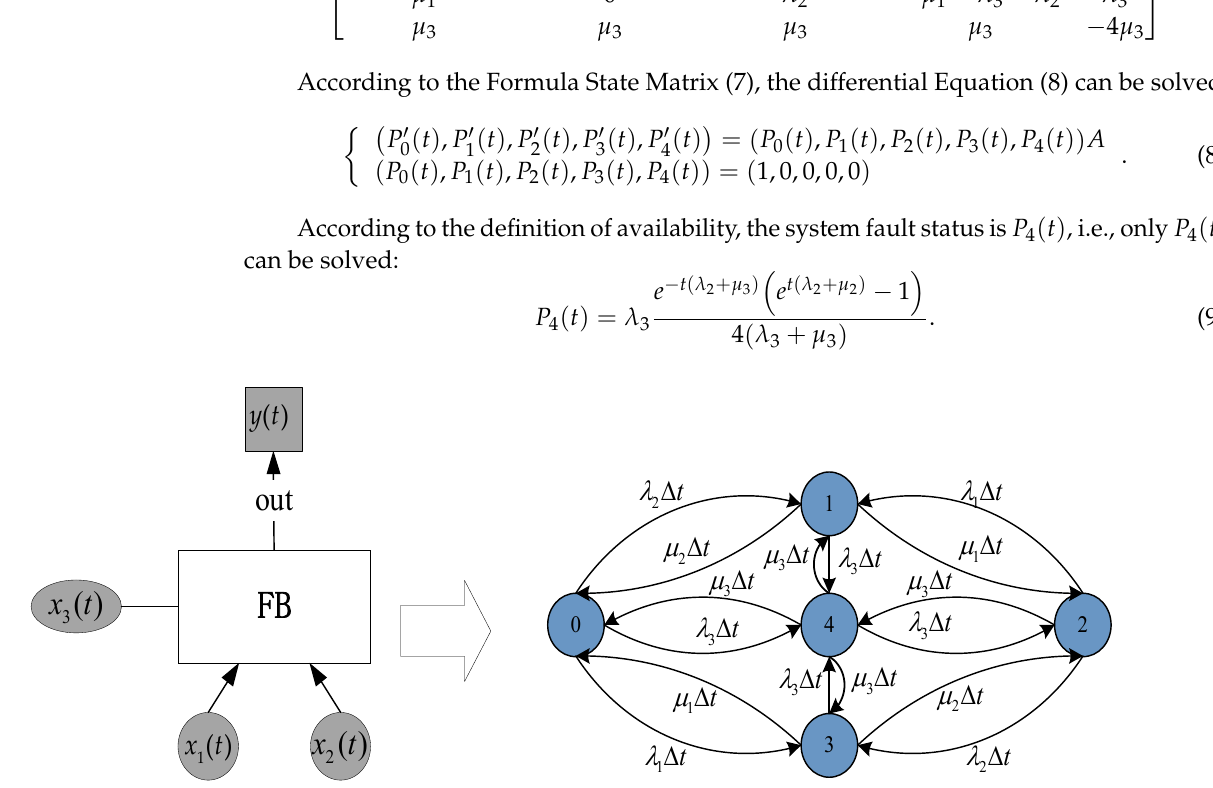
Figure 4. The transformation of the feedback gate into a Markov model.